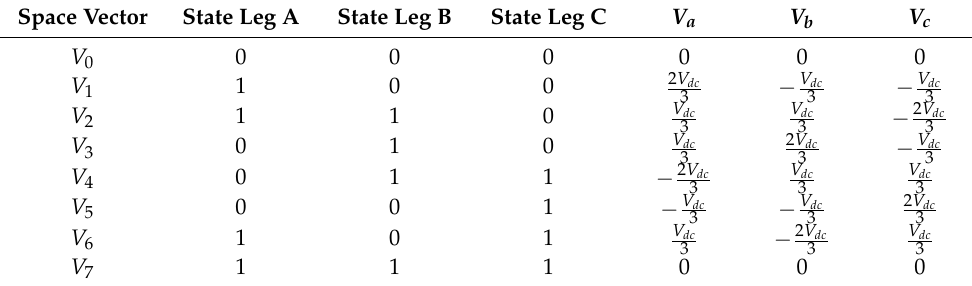
Table 1. Summary of the possible space vectors for three-phase inverter. Space Vector